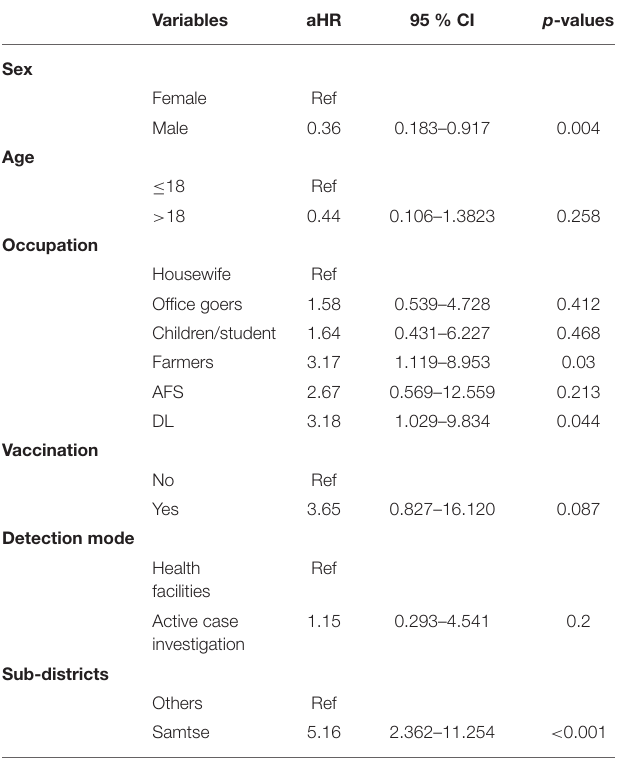
TABLE 2 | Determinants of COVID-19 symptoms using Cox proportional hazard analysis, Samtse District,